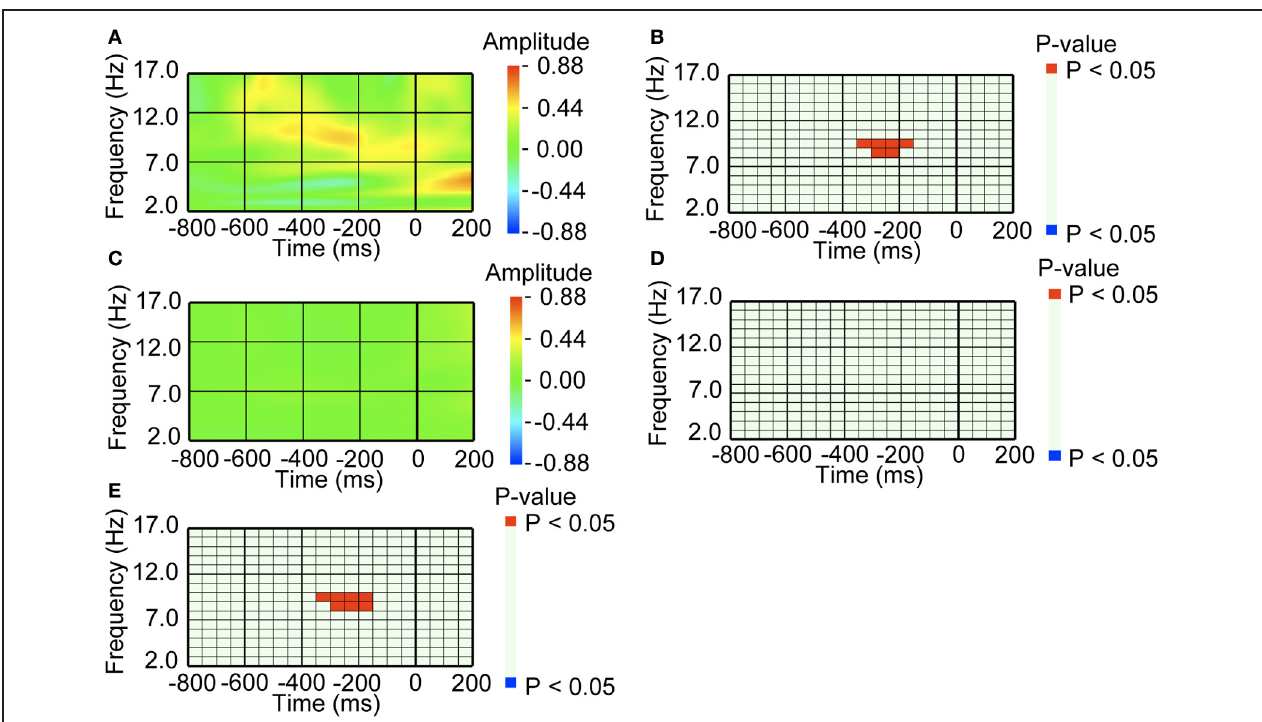
FIGURE 2 | An amplitude increase in occipital alpha band activity preceded blinking, when blinking was followed by perceptual switching. (A) Average waveform of the occipital recordings (O2) aligned with the pre-switch blinkings that were followed by perceptual switching. The amplitude was Z-transformed, and the amplitude zero indicates baseline amplitude. (B) Statistical difference between average waveform aligned with the pre-switch blinkings and baseline amplitude. The colors red and blue denote that amplitude was larger in average waveform or baseline amplitude, respectively ( P < 0 . 05). (C) Average waveform of the occipital recordings (O2) aligned with the no-switch blinkings that were not